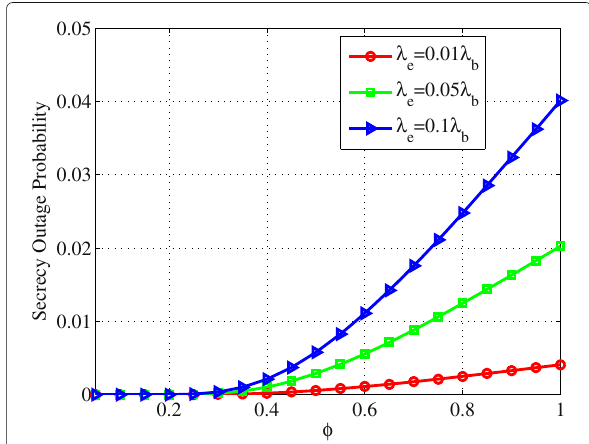
Fig. 6 The secrecy outage probability of the typical cellular link in scenario I versuspowerallocation ratio φ . Figure 6 depicts the relationship between the secrecy outage probability of the typical cellular link and the power allocation